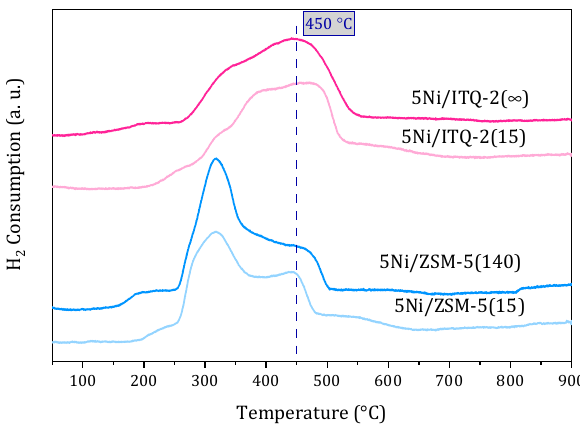
Figure 2. H 2 -TPR profiles of the 5 wt.% Ni catalysts supported on ITQ-2 and ZSM-5 with different Si/Al ratios.